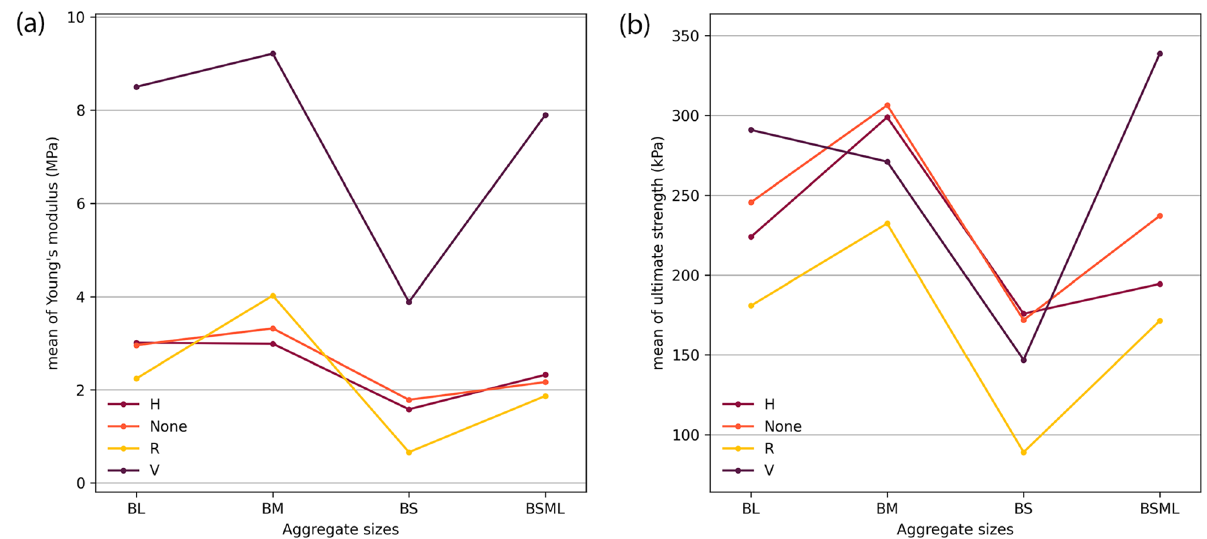
Figure 6. Parameters interaction graph for Young’s modulus ( a ) and ultimate strength ( b